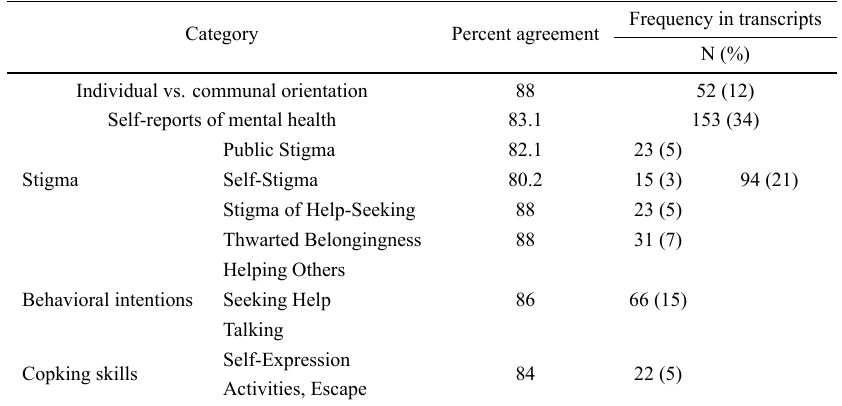
Table 2. Percentage agreement between coders and percentage of passages in which coding categories appeared (See Appendix Table 7 for all coding